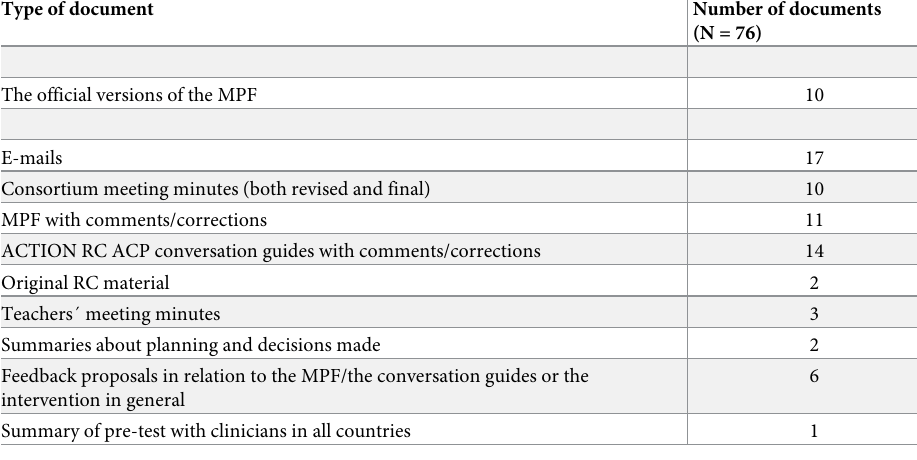
Table 3. Overview of the various kinds of textual data that was applied and